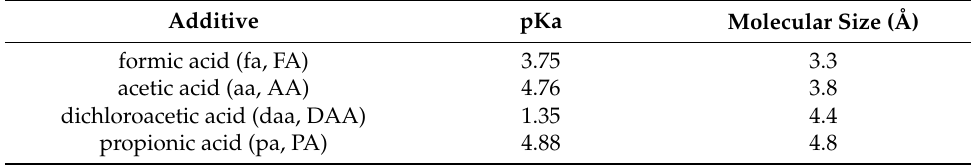
Table 1. pKa and molecular size values for the chosen